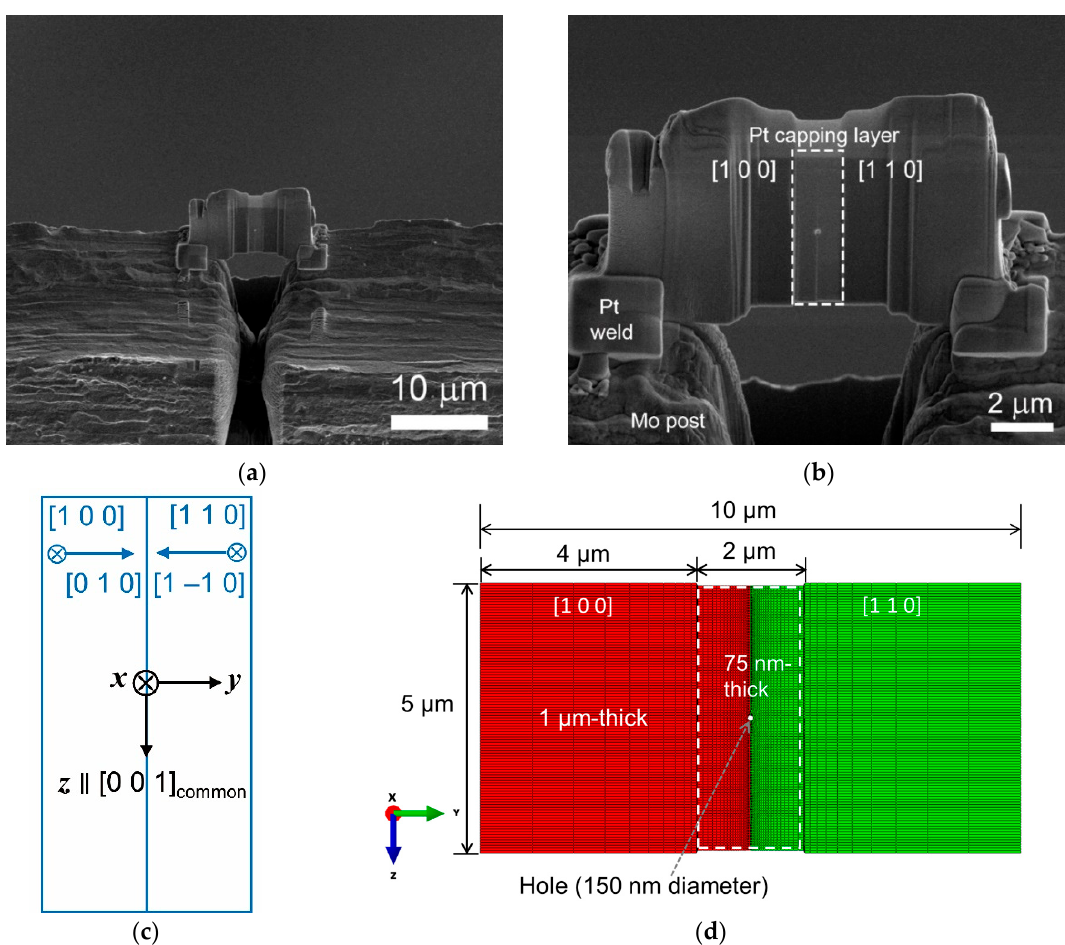
Figure 1. ( a ) Scanning electron microscopy image of a typical focused ion beam (FIB) specimen examined in the present work; ( b ) higher magnification of ( a ); ( c ) crystallographic orientations of the Ni lamella; and ( d ) Finite element model for the heating experiment with similar dimensions of the Ni lamella of the FIB specimen.